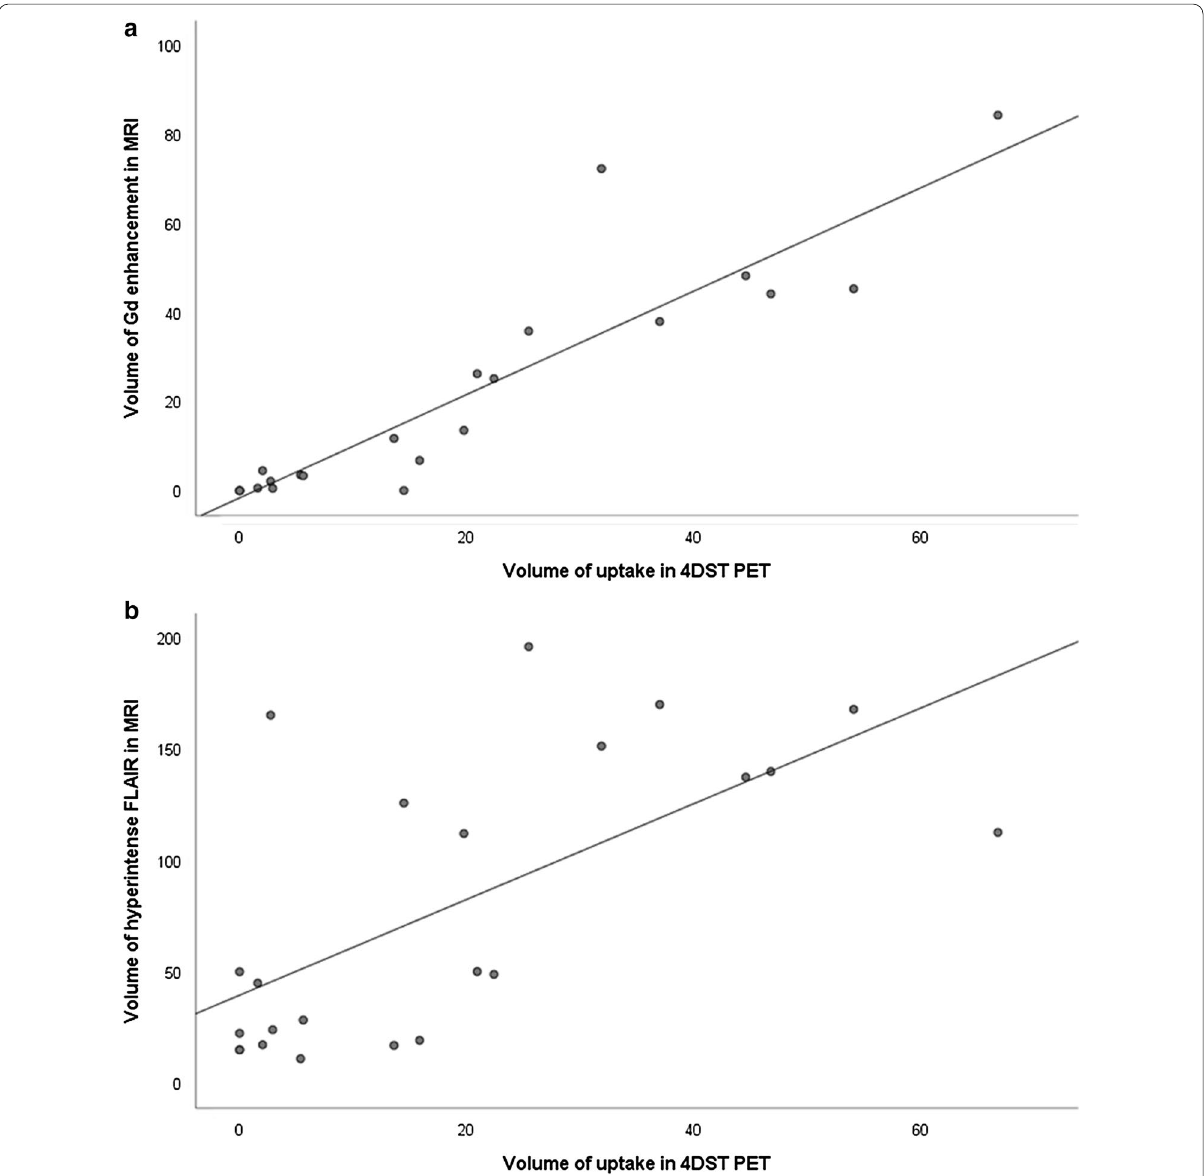
Fig. 3 Plot of the volume of 4DST uptake and Gd enhancement in MRI ( a ), showing a significant correlation of the two parameters (Spearman correlation coefficient 0.941, P < 0.001). Plot of the volume of 4DST uptake and hyperintense FLAIR in MRI ( b ), showing a significant correlation of the two parameters (Spearman correlation coefficient 0.682, P <